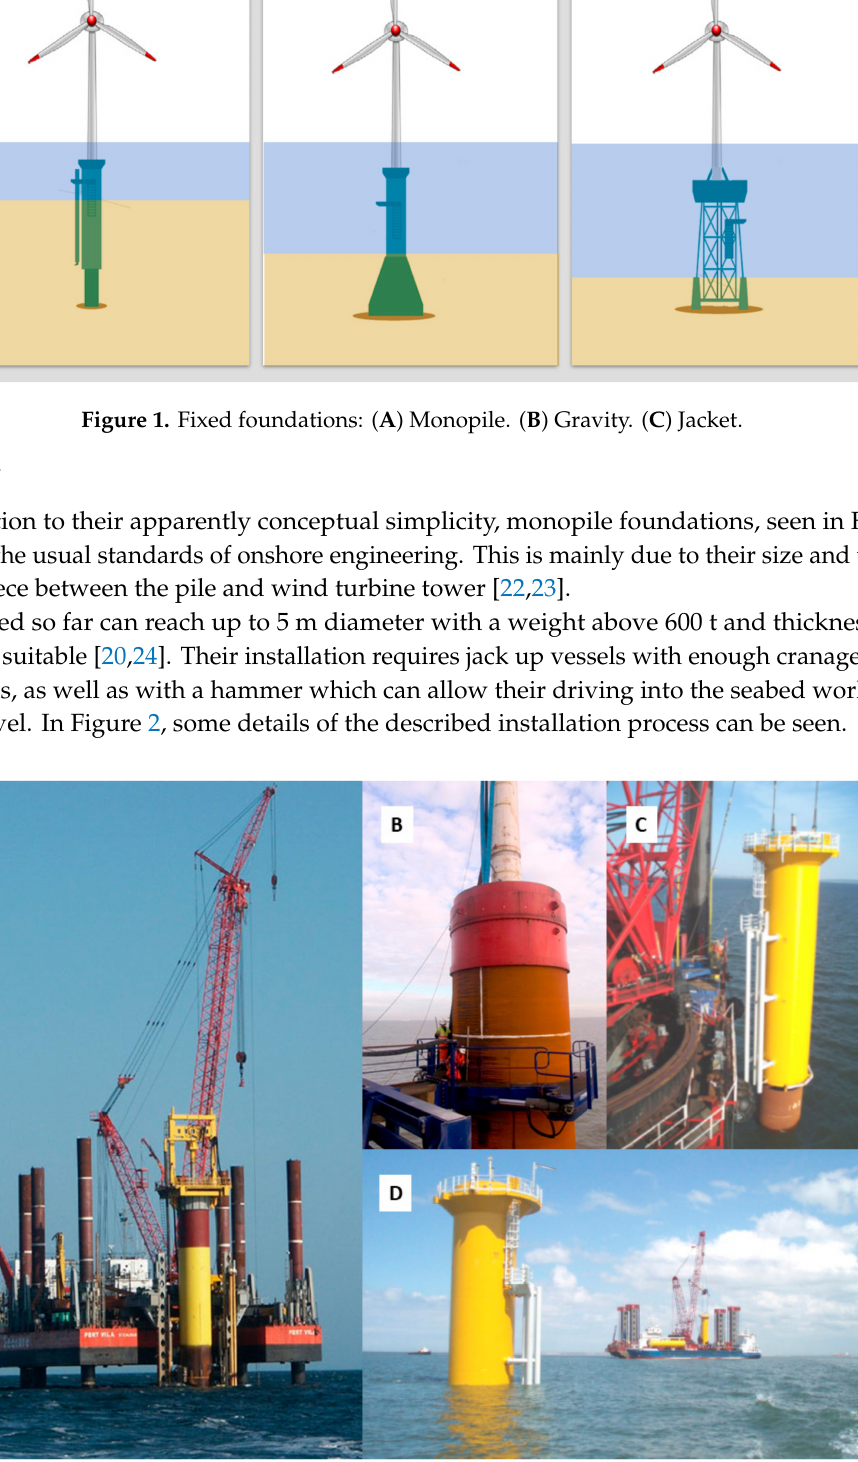
Figure 2. (A ) Jack-up during a monopile installation at North Hoyle (UK). ( B ) Drilling of a monopile. Kentish Flats (UK). ( C ) Transition piece installation. ( D ) Monopile installation